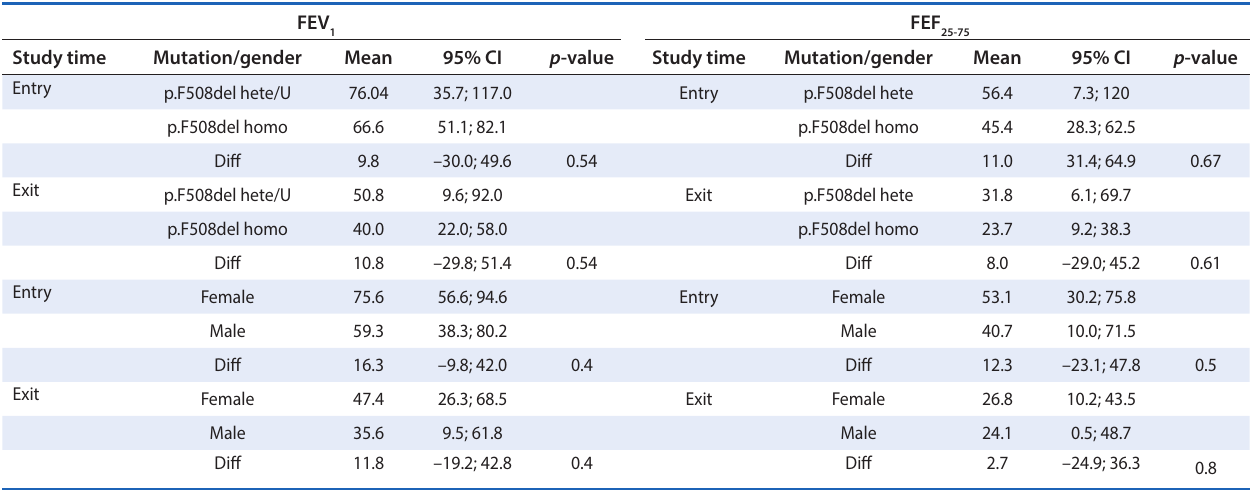
Notes: CI = confidence interval; FEV1 = forced expiratory volume; FEF25-75 = forced expiratory flow during 25 – 75%; p.F508del hete/U = p.F508del heterozygous and unidentified mutations; p.F508del homo = p.F508del homozygous; entry = study entry; exit = study exit; Diff = difference between mutations mean or gender